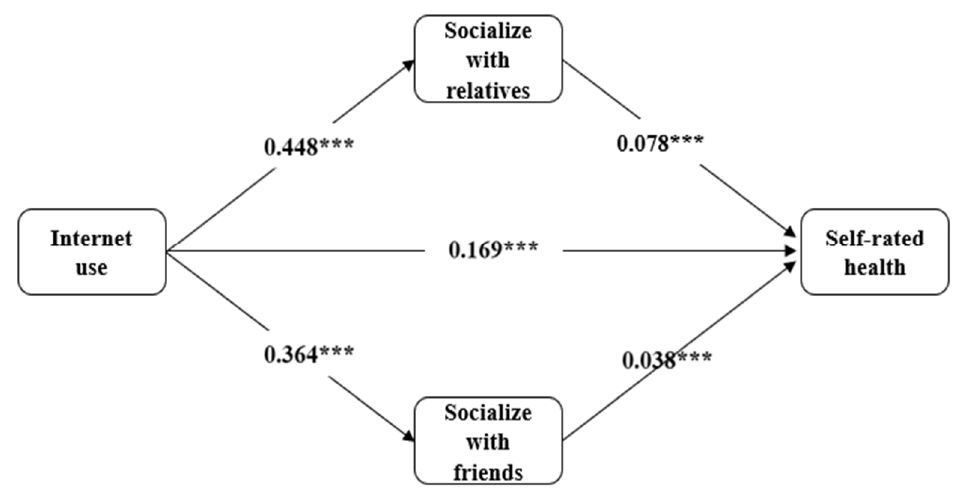
Figure 2. The Mediating Relationship Between Internet Use and Self-rated Health and the Non- standardized Regression Coefficients (Matched Samples): Standard errors in parentheses *** p < 0.01.